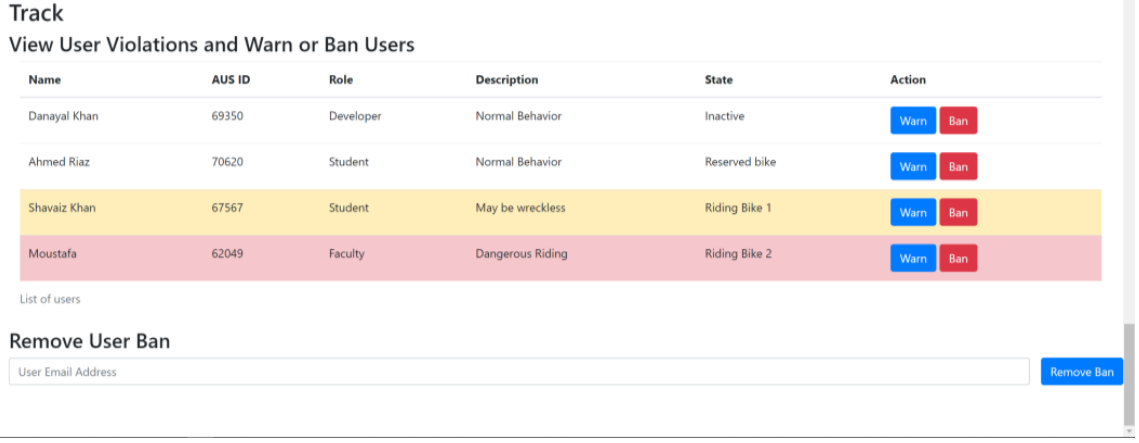
Figure 11. Track Users Administrator View in the Web Portal.